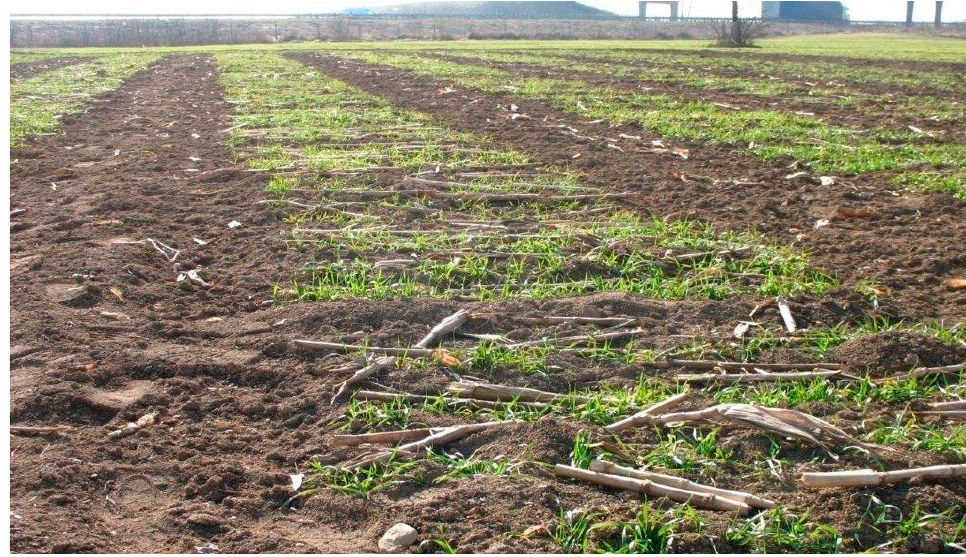
Figure 1. Maize stalk residue deployed in the field at the location of Botinec in 2011.